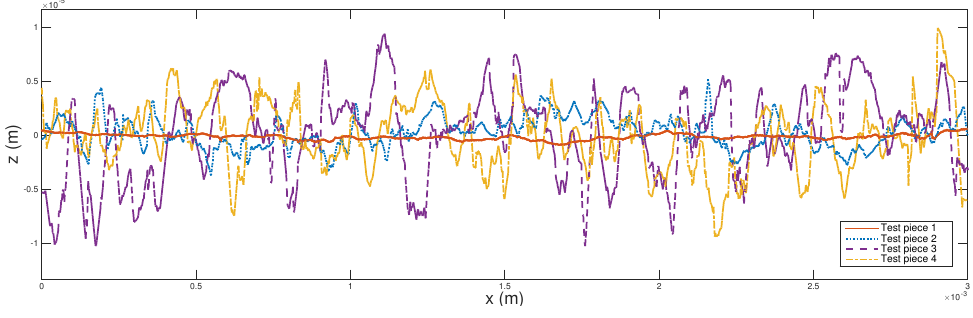
Figure 4. The cross-sectional profile of the four test